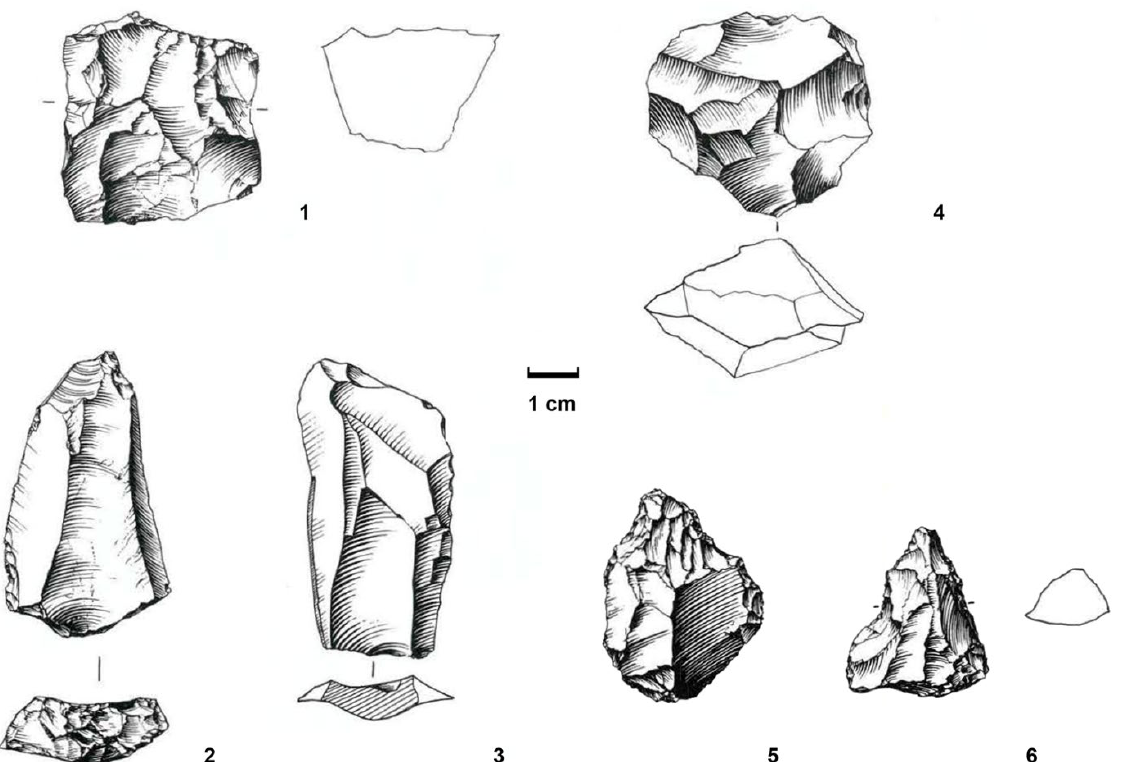
Figure 6. Reduction sequences on basalt (1, 2, 3) and quartz (4, 5, 6). Modified after Chavaillon and Chavaillon